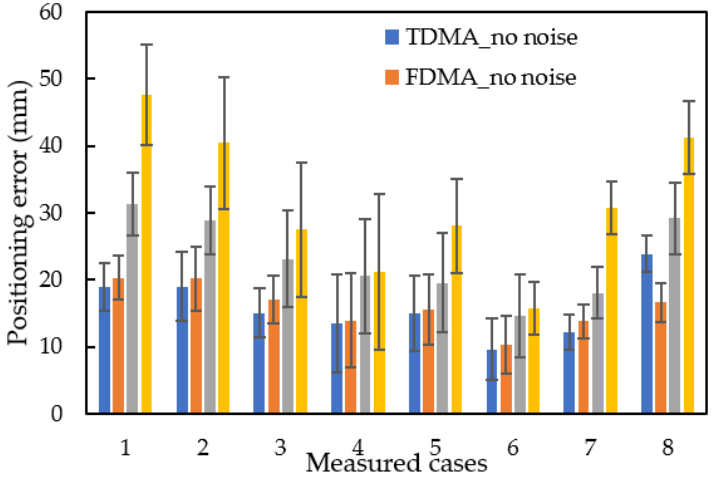
Figure 11. Positioning error.